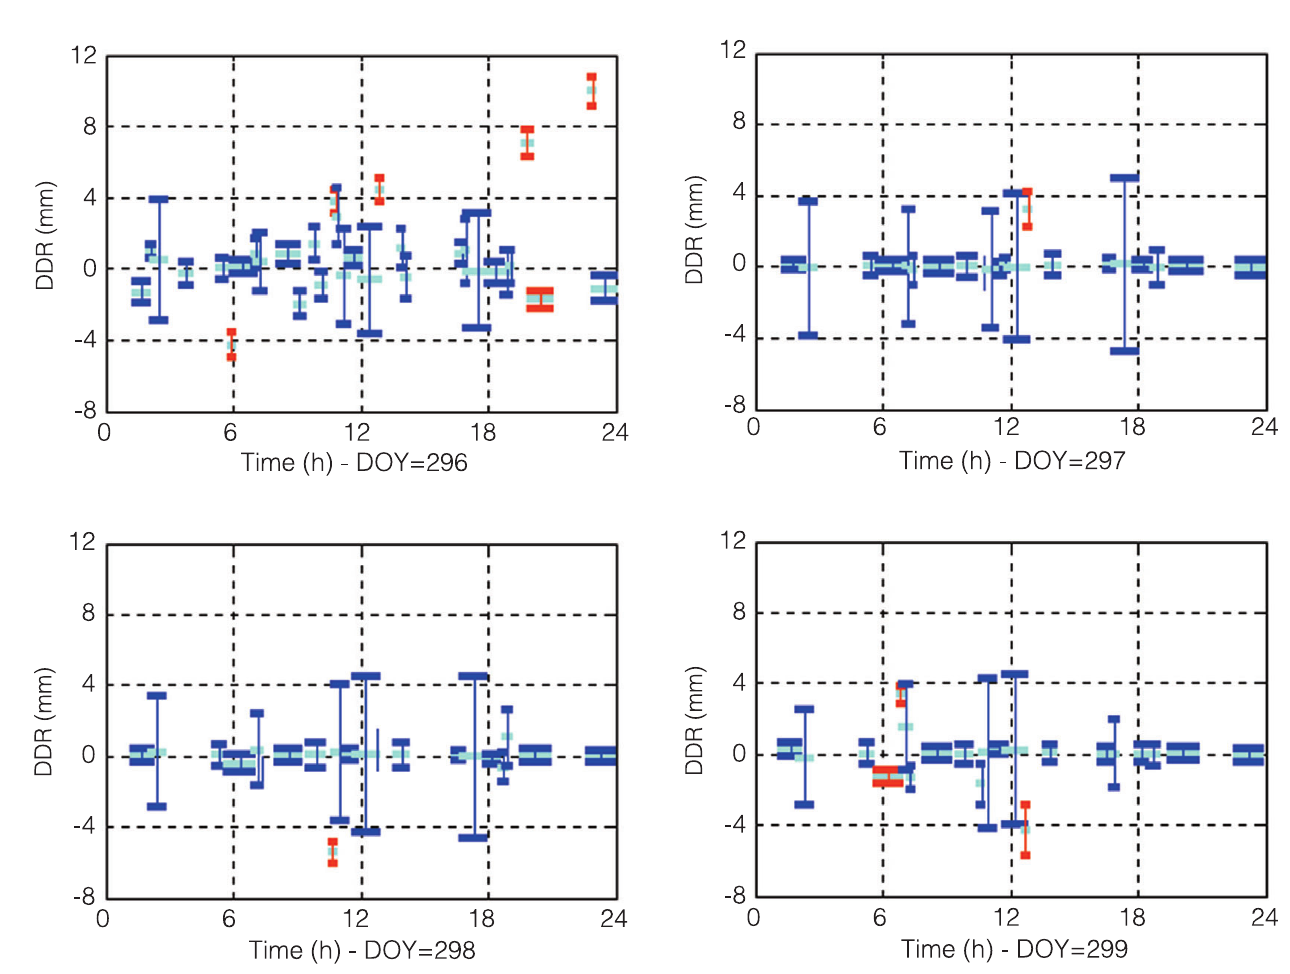
Fig. 3. Double differences residuals versus time for DOY: 296, 297, 298 and 299 of the year 1999 for the GPS stations Padua and Medicina (Italy). Lines: cyan-mean DDR; blue-standard deviation; red-anomalous